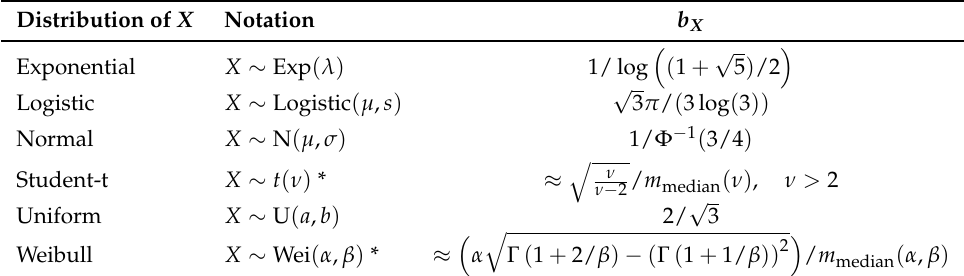
Table 1. Consistent factor b X of the indicated distribution.